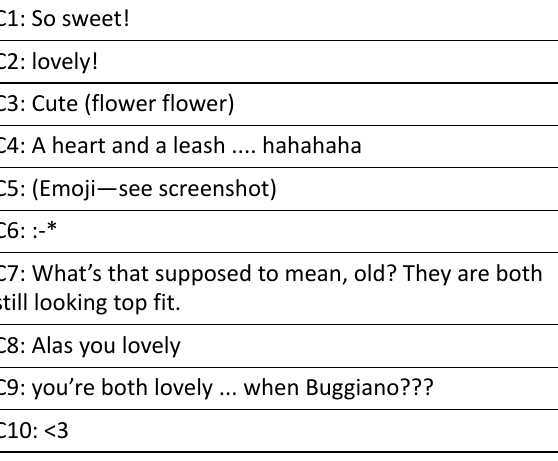
Table 2. English translation of German comments which are visible in Figure